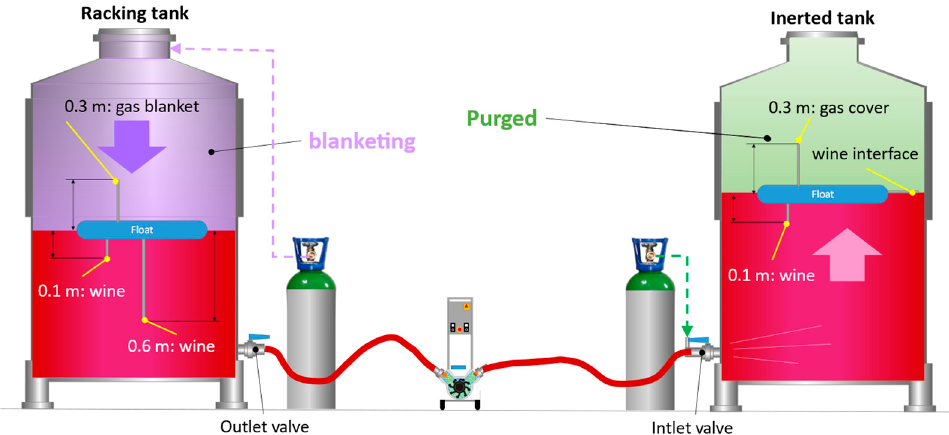
Figure 2. Arrangement of the application of gases for purging, blanketing, and oxygen monitoring during wine racking. Detail of the placement of oxygen measurement probes fixed on the float.